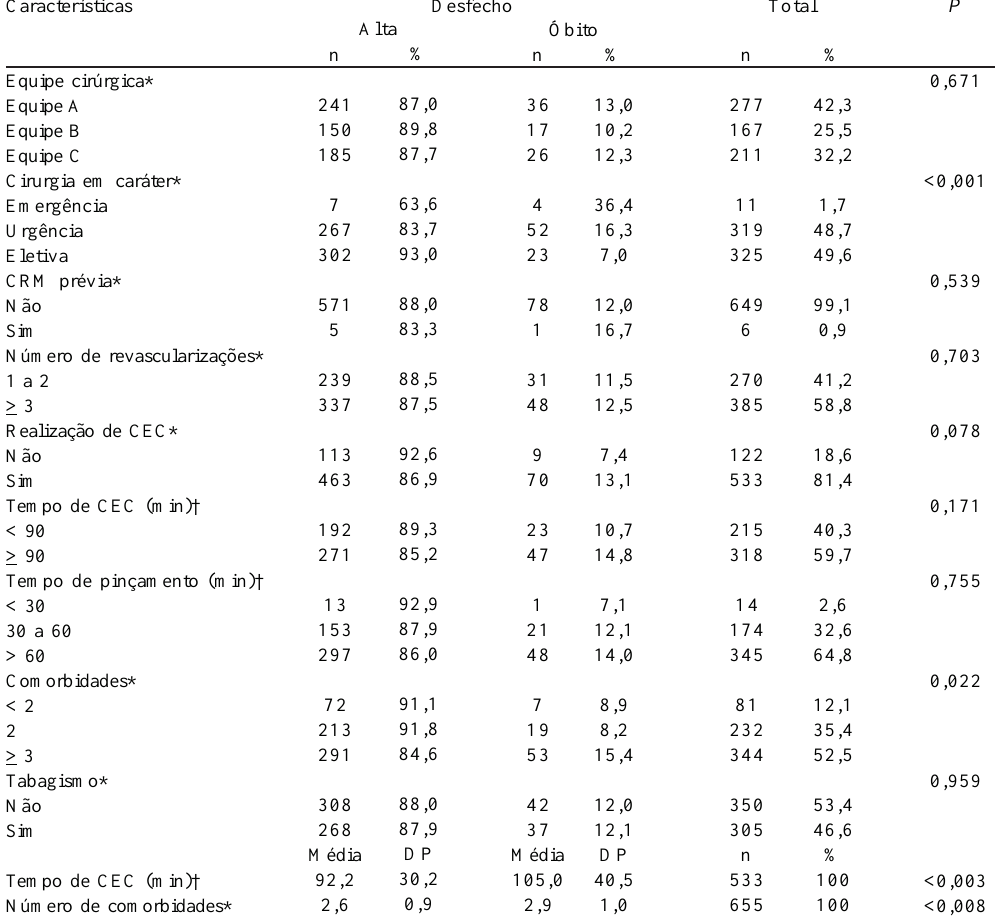
tabagismo foi observado em 46,6% dos